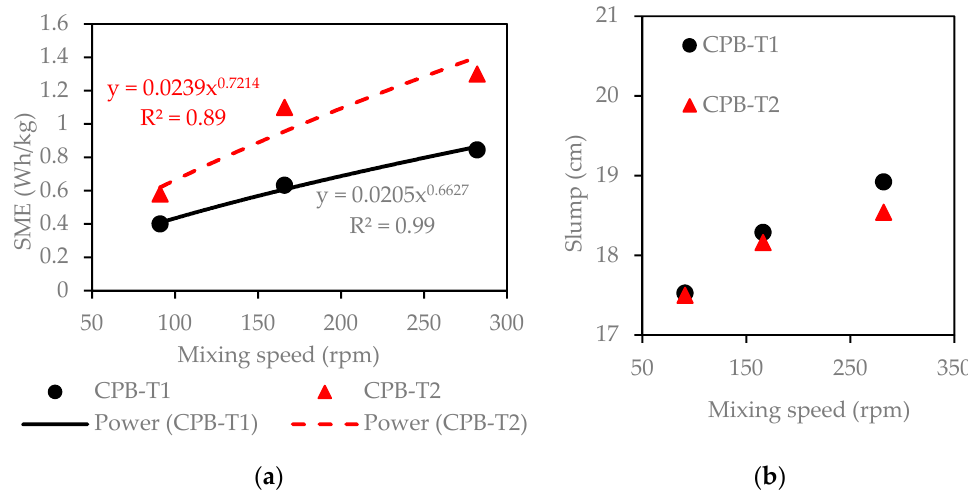
Figure 7. Influence of mixing speed on: ( a ) SME and ( b ) consistency for CPB-T1 (M06–M08 and CPB-T2 (M18–M20) at a mixing speed of 91, 166, and 282 rpm for a mixing time of 5 min using the Omcan SP300AT mixer.